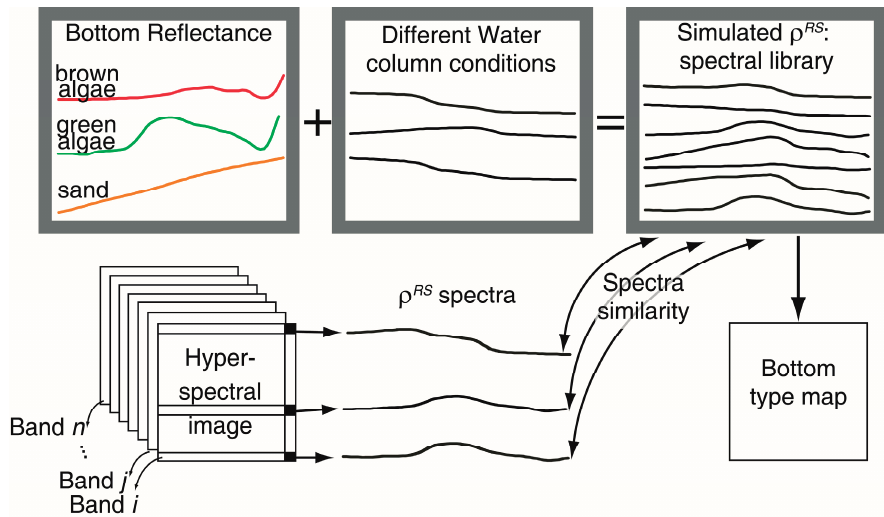
Figure 4. Graphic representation of the approach using Look Up Table matching to generate bottom type map without effect of water